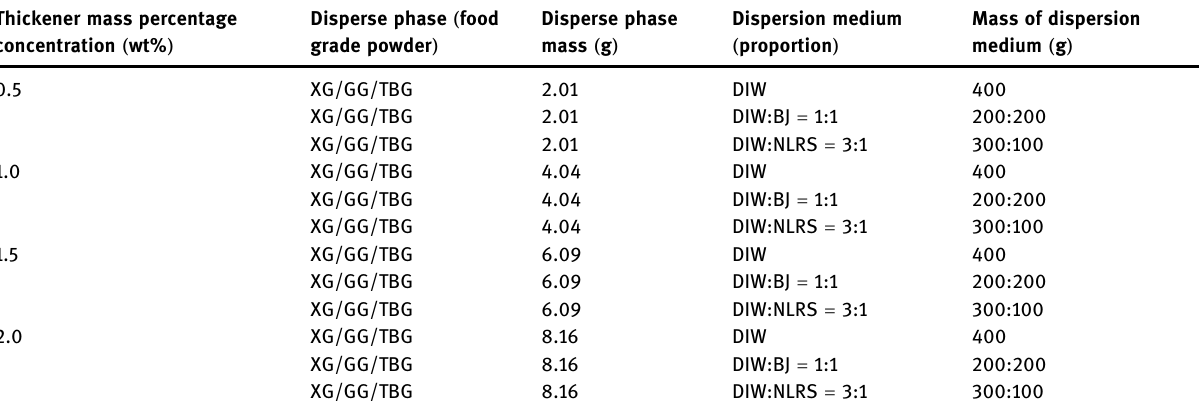
Table 2: Thickening liquid dispersion phase and dispersion medium Thickener mass percentage concentration ( wt%